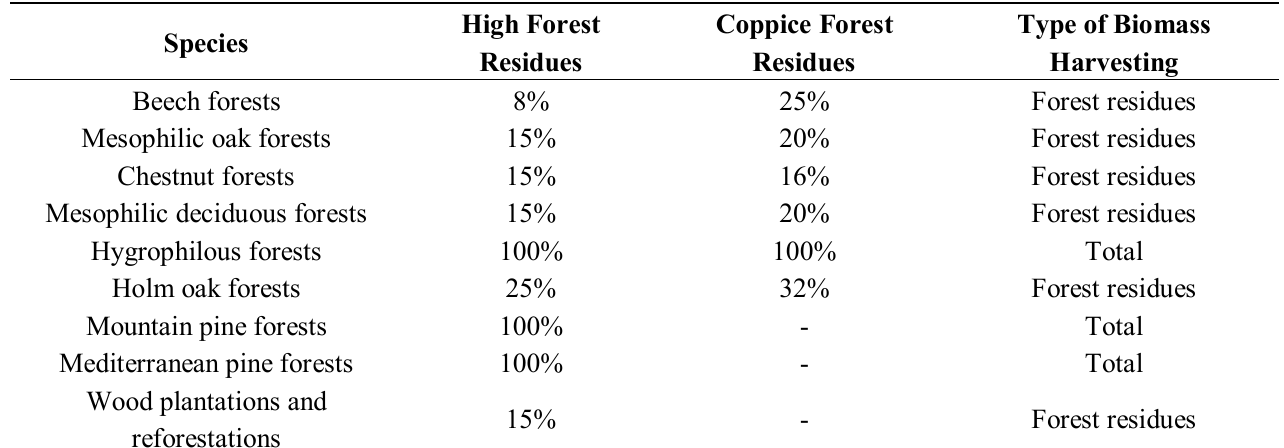
Table 2. Harvested biomass (in %) for each